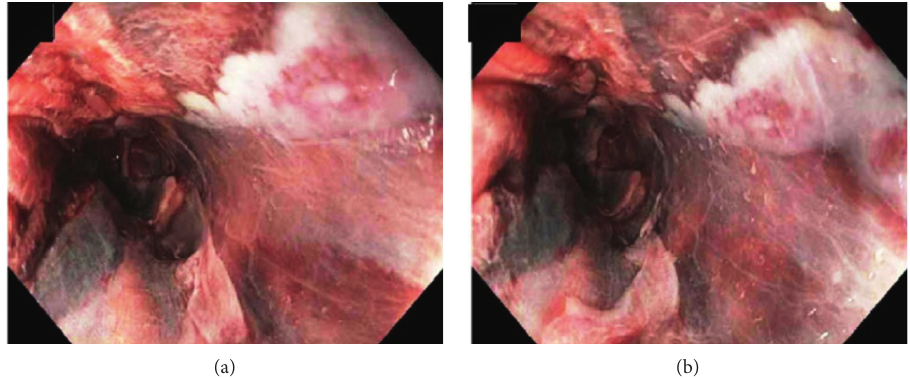
Figure 2: Endoscopic images showing extensive circumferential esophageal ulcerations with blackish discoloration.